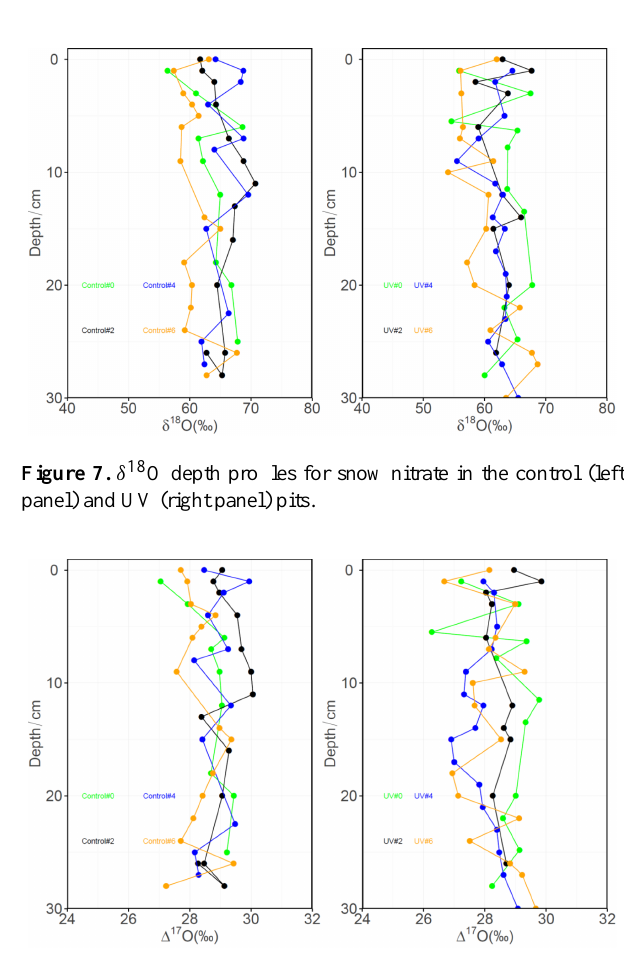
Figure 8. Same as Fig. 7 but for (cid:49) 17 O.